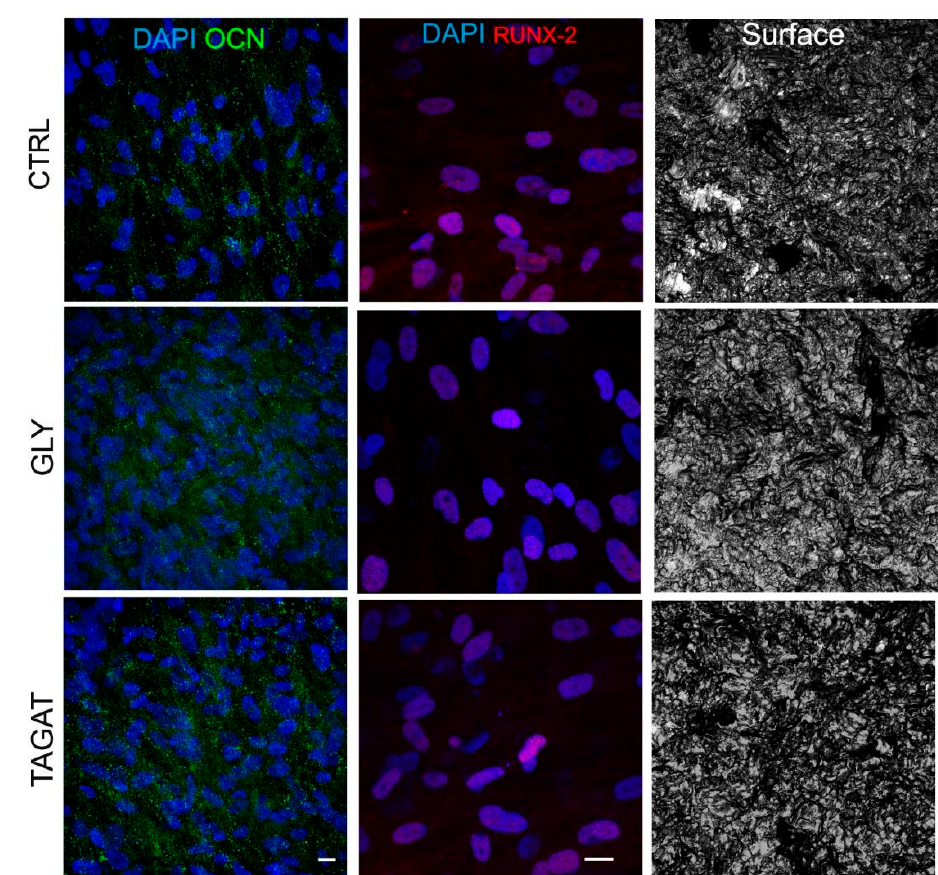
Figure 6. Osteogenic commitment of hDPSCs on titanium disks. Confocal immunofluorescence analysis of osteocalcin (OCN) and RUNX-2 were carried out on hDPSCs seeded on titanium disks previously cleansed with GLY and TAGAT. Control group (CTRL) consisting of hDPSCs seeded on untreated titanium surfaces. Nuclei were counterstained with DAPI. Scale bar = 10 µm.